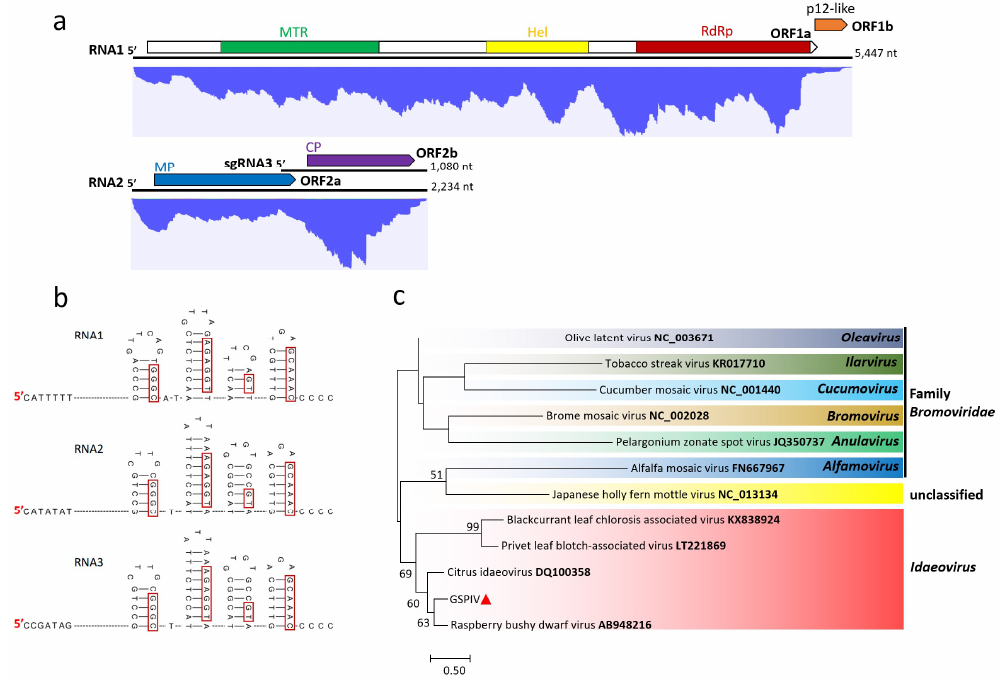
Figure 3. ( a ) Genomic structure of green Sichuan pepper-idaeovirus (GSPIV) and distribution